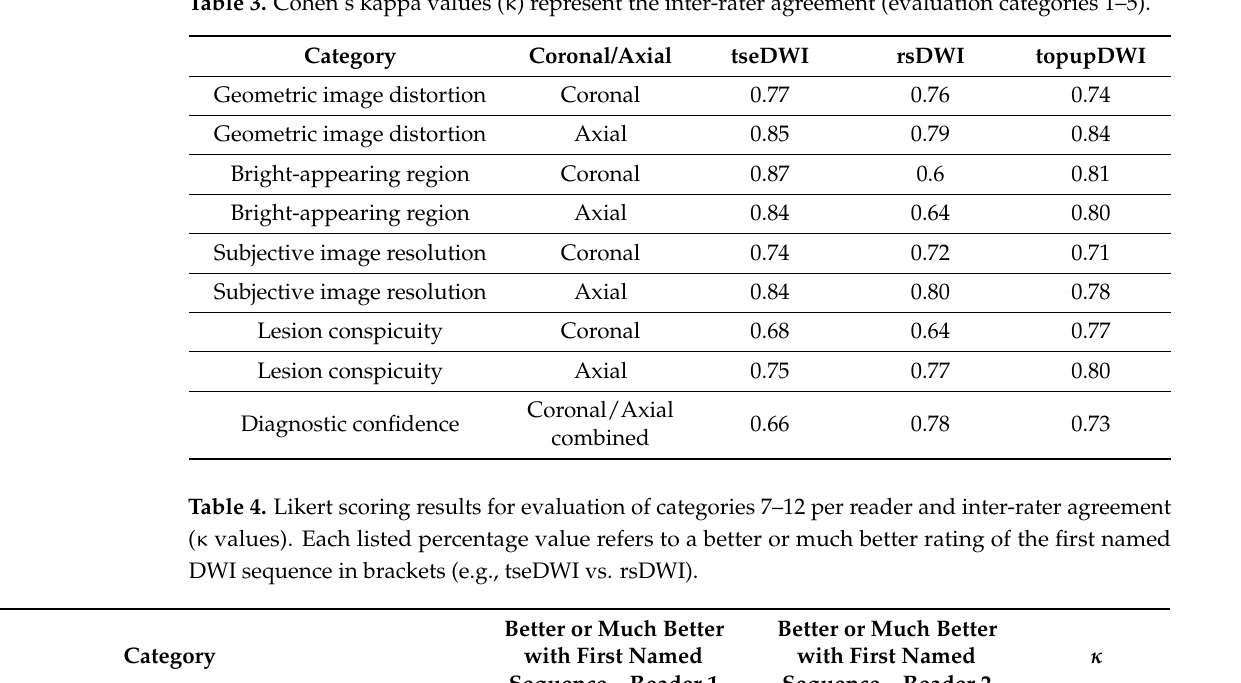
Table 3. Cohen’s kappa values ( κ ) represent the inter-rater agreement (evaluation categories 1–5).